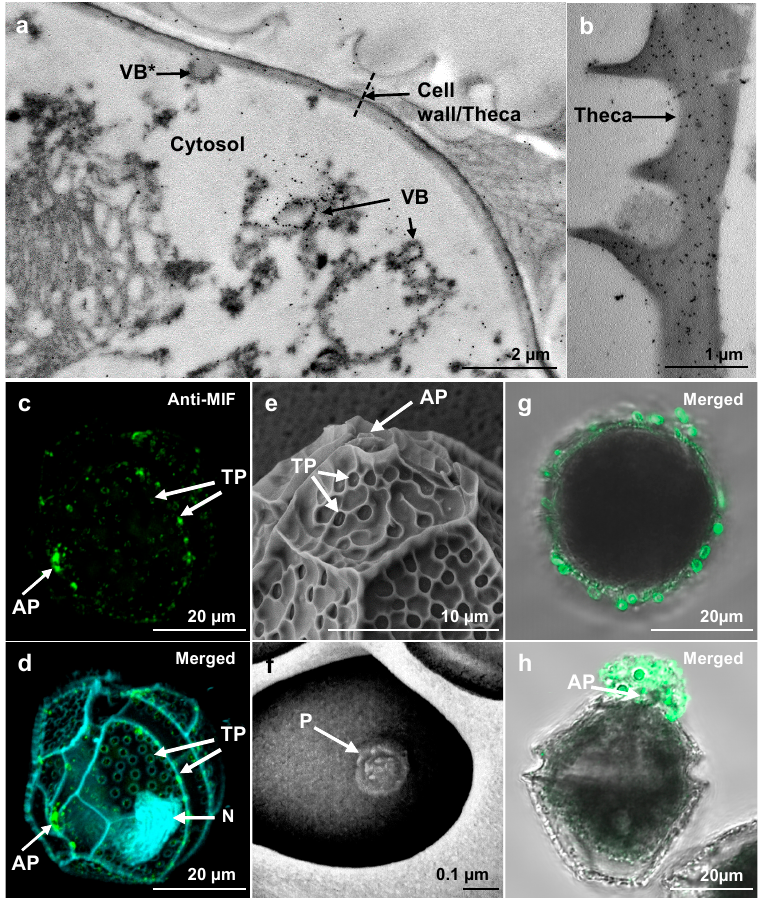
Figure 2. Subcellular localization of LpMIF. ( a , b ) TEM of immunogold-labeled L. polyedra cells showing the accumulation of gold particles (black dots) in membranes of the vesicular bodies (VB) and in the theca. Note that one of the vesicular bodies (indicated by a star) appears to be in a process of fusion with the cell wall. ( c , d ) Immunolocalization of LpMIF by confocal microscopy. LpMIF is labelled in green in ( c , d ), while the nucleus (N) appears in blue in ( d ) (DAPI staining). The overall structure of L. polyedra is visible under UV light due to autofluorescence in ( d ), and shows the shape of the thecal plates, the apical pore (AP), and the thecal pores (TP). Note the accumulation of LpMIF at the apical pore (AP) and the thecal pores (TP). ( e , f ) Scanning electron micrographs of L. polyedra showing the AP and TP. An enlargement of a TP in ( f ) shows the inner pore (P). ( g , h ) Representative pictures of L. polyedra cells that have been immunofluorescence-labelled under mild washing and fixing conditions, revealing the accumulation of MIF-labelled extracellular vesicles. Here, an apical view of the cell shows labelled vesicles surrounding the cell ( g ) and a lateral view illustrate the commonly observed accumulation of labelled mucus at the apical pore (AP). Control samples exposed to pre-immune serum or no primary antibody did not show any fluorescent signal (Figure S1e,f). Please see Supplementary Materials for procedure